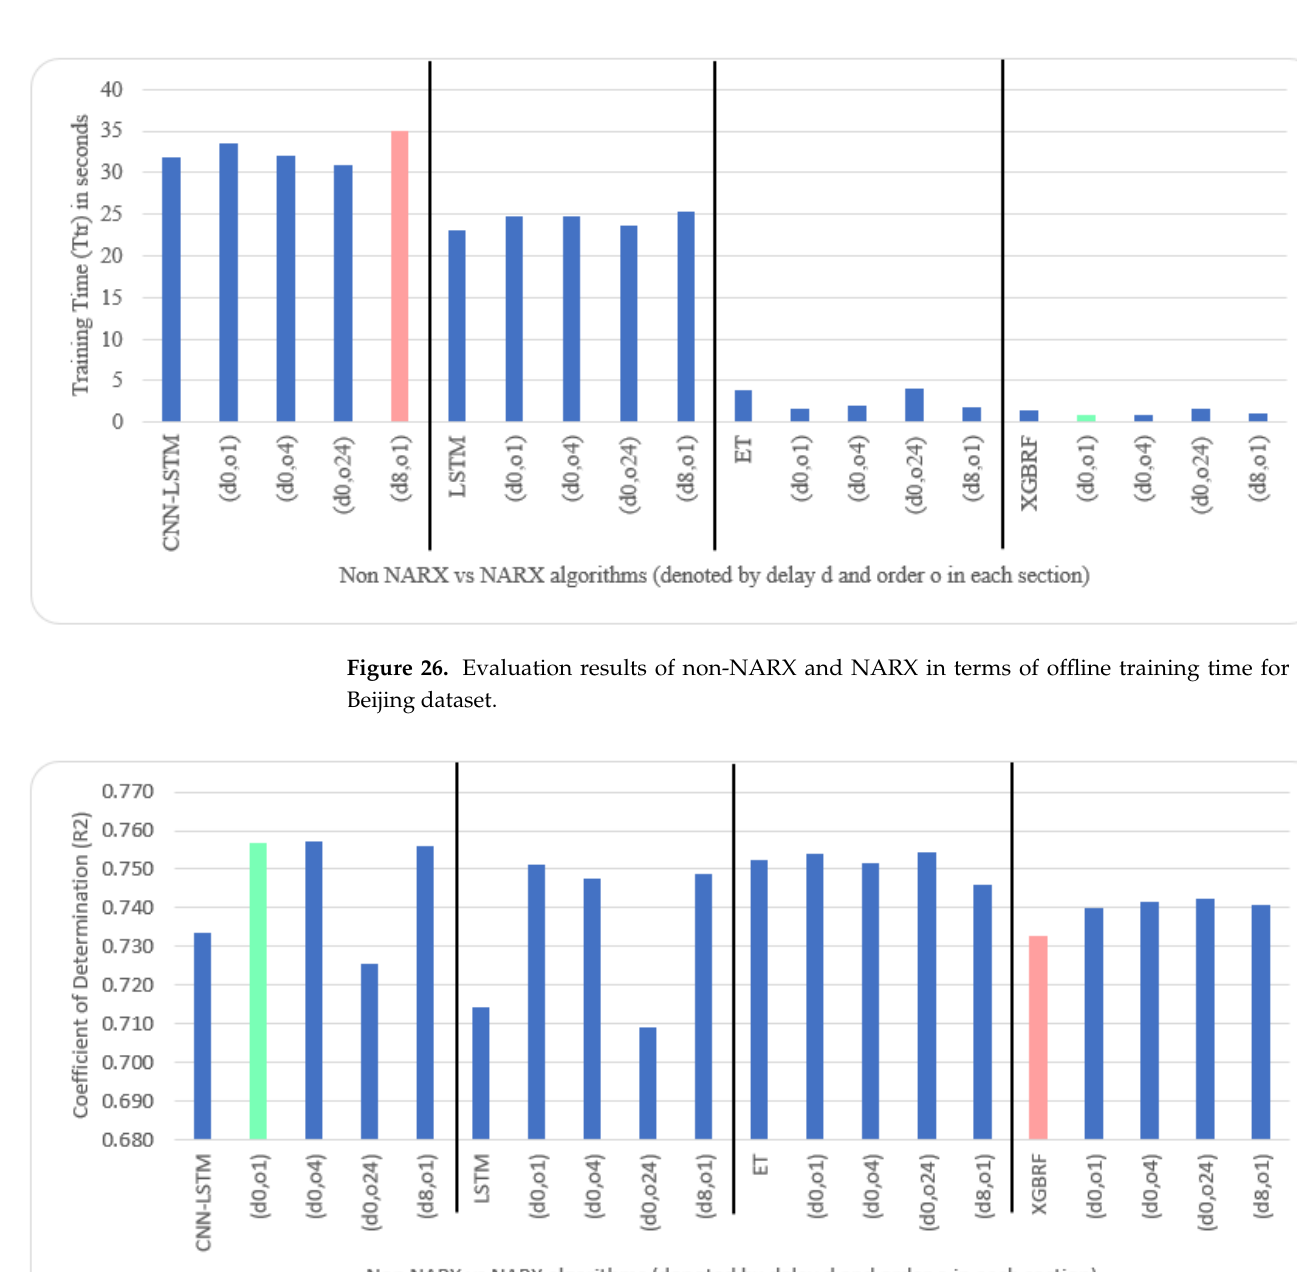
Figure 25. Evaluation results of non-NARX and NARX in terms of normalised root mean square error for the Beijing dataset.